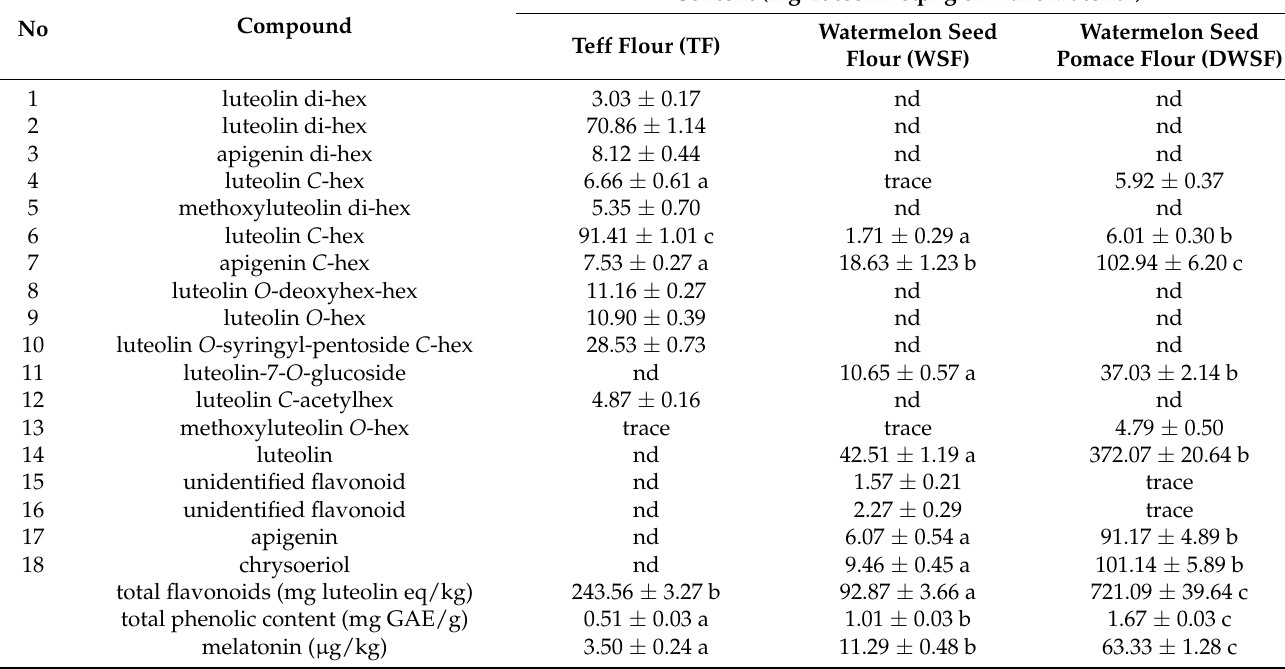
Table 3. Flavonoid, total phenolic (TPC), and melatonin content in teff and watermelon flour material (mean ±